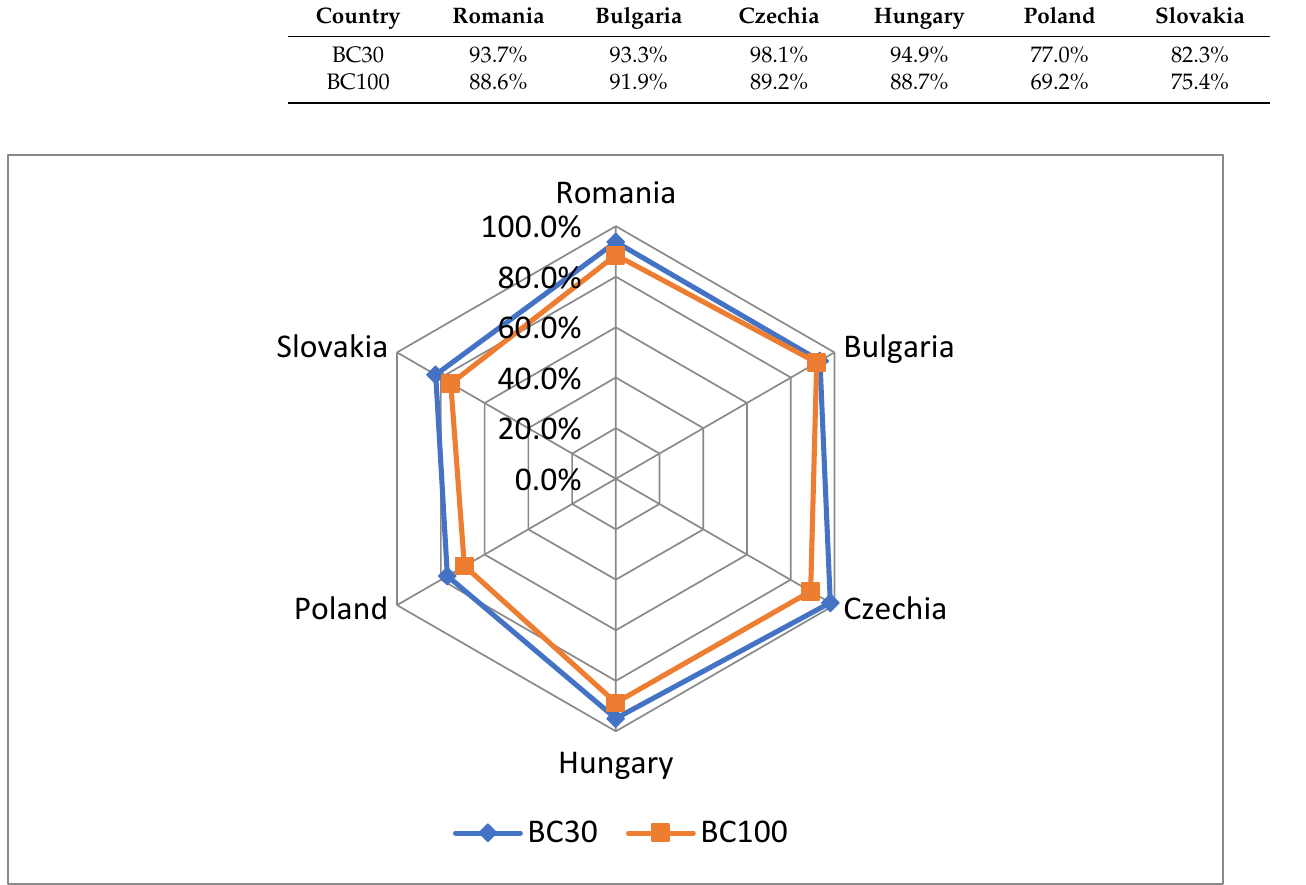
Figure 1. Fixed broadband networks coverage by speed in 2021 .